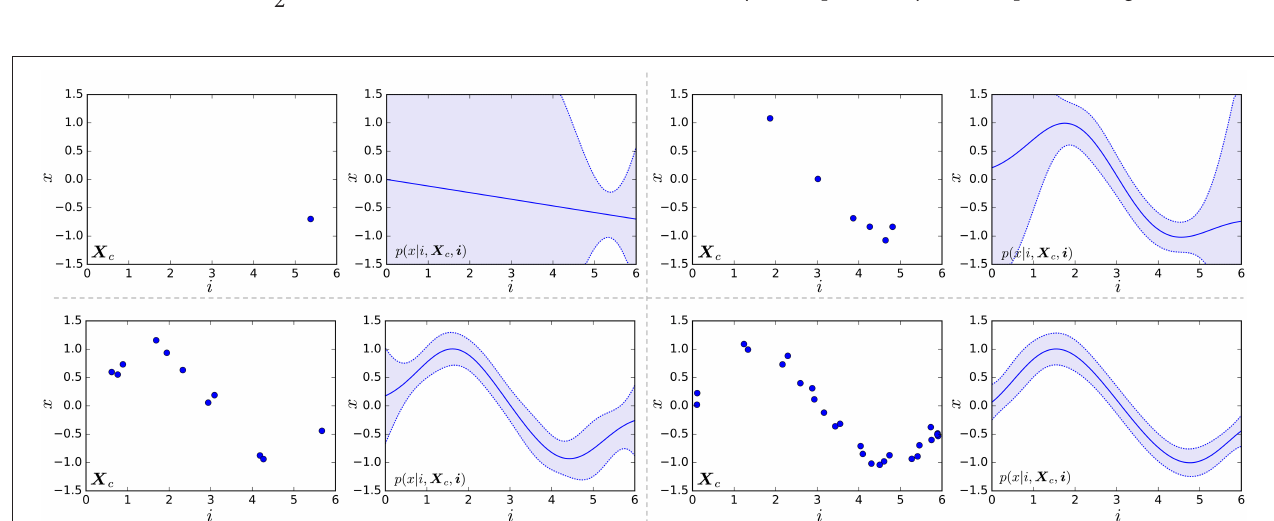
FIGURE 4 | Examples of Gaussian processes. Left graph in each pair of graphs represents learning data points ( i , X c ). Right graph shows the learned probabilistic distribution p ( x | i , X c , i ); the solid line represents the mean, and the blue region represents the range of standard deviation.